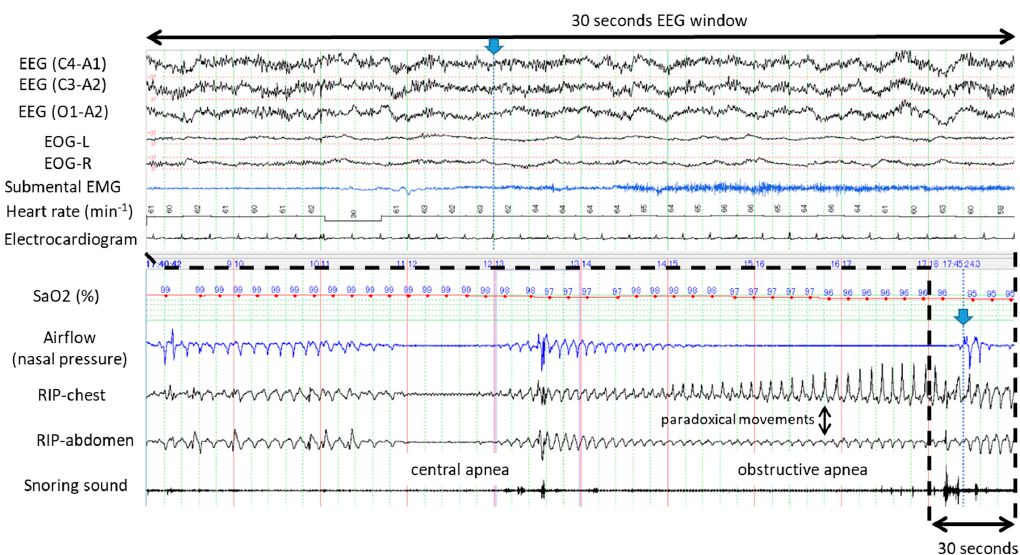
Figure 2. Five-minute polysomnographic tracings demonstrating restorations from long central and obstructive apneas without desaturation and cortical arousal during ESD procedure under propofol sedation. The arrow indicates abrupt termination of obstructive apnea without electroencephalograms (EEG) change suggesting cortical